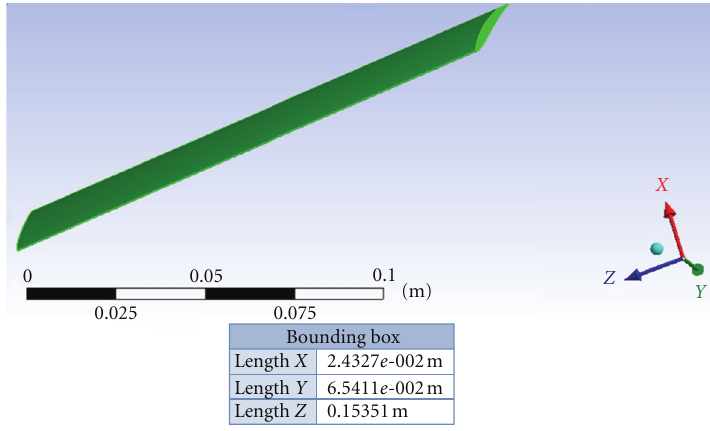
Figure 5: 150 mm long rotor blade model.